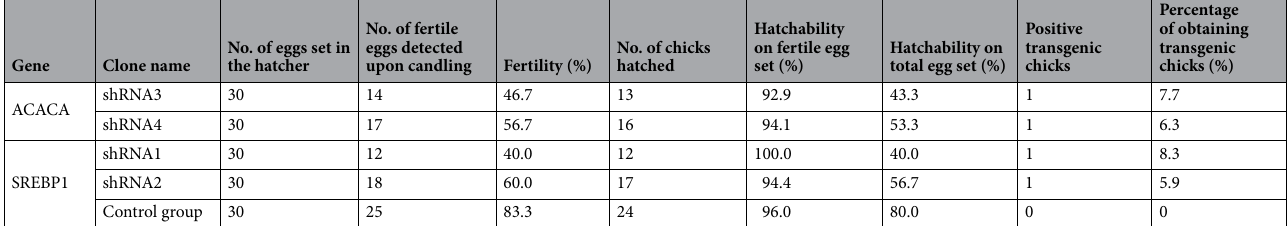
Table 1. Hatching performance of birds in transgenic and control groups during 1st generation. Fertile eggs were incubated in the egg incubator and candling was done on 18th day to screen the fertile eggs. On 18th day, ggs were incubated in the hatcher and chicks were hatched on 21st day. Two shRNA clones each of ACACA and SREBP1 genes were transferred to the host through sperm mediated gene transfer and the transfected sperms were inseminated to the hens under treatment group while normal sperms were inseminated to the hens under control group. Fertile eggs from both treatment and control groups were collected for hatching to